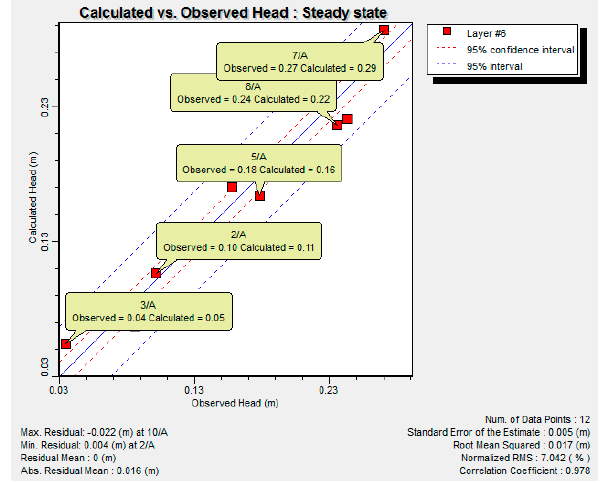
Figure 7. Calculated and observed head in study area.